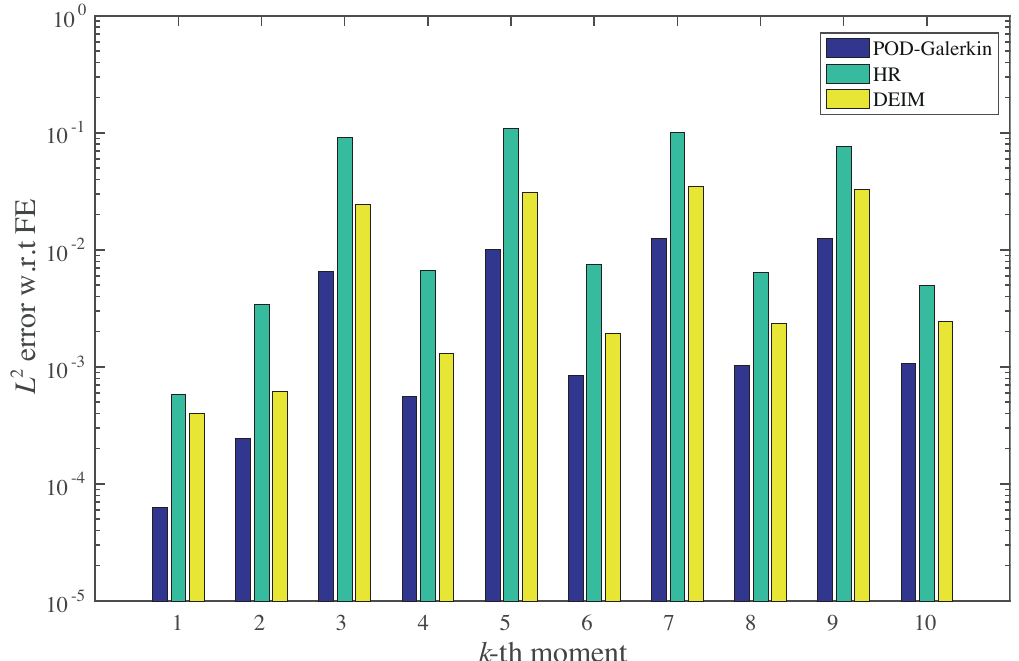
Figure 5. L 2 ( Ω ) error of the centered moments w.r.t. the finite element solution. Please note that we have set m 1 (cid:63) : = ¯ u (cid:63) for simplicity of